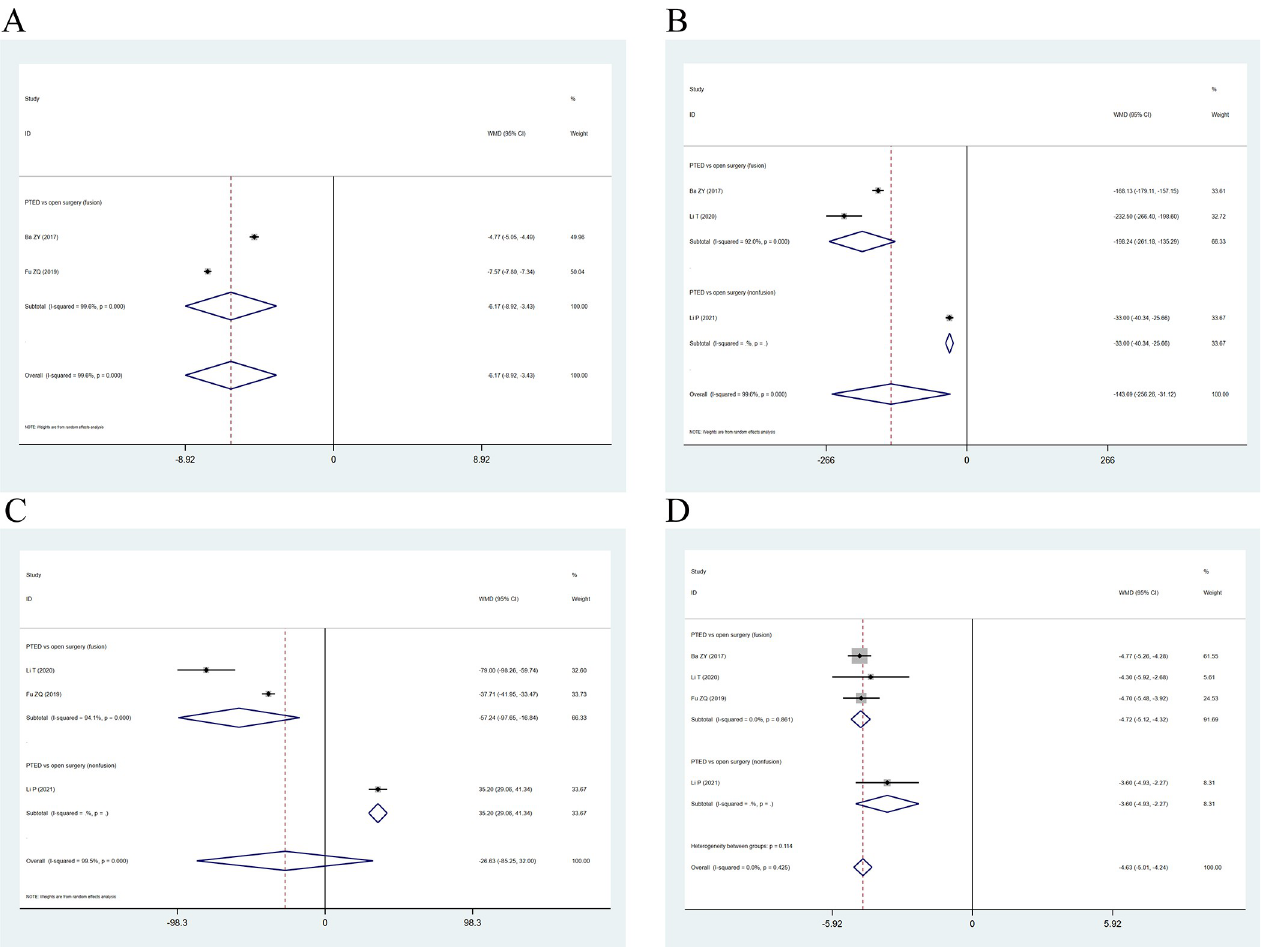
Fig 6. Forest plots for surgical indicators. (A) The length of skin incision; (B) The intraoperative bleeding; (C) The operative time; (D) The hospitalization